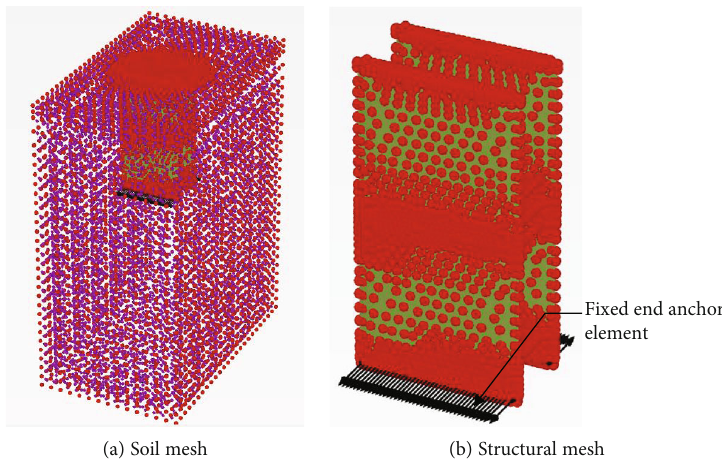
Figure 8: Mesh generation of the soil and structural elements in PLAXIS-3D.